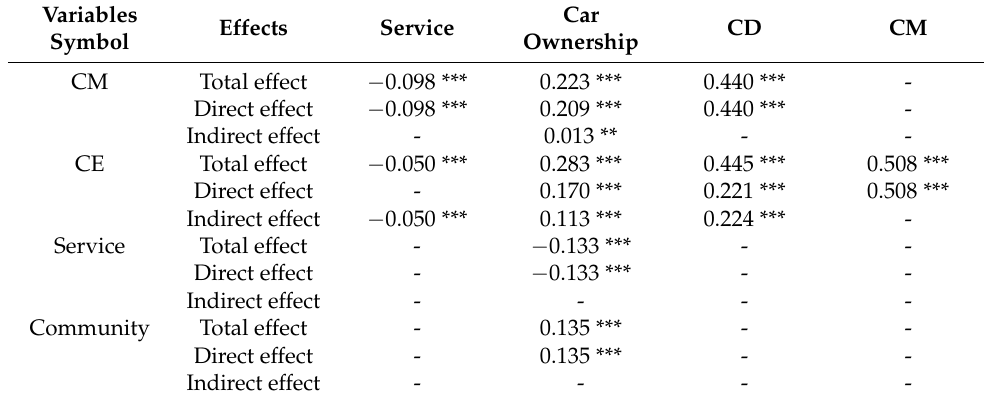
Table 10. Standardized direct, indirect and total effects of endogenous variables on one another.